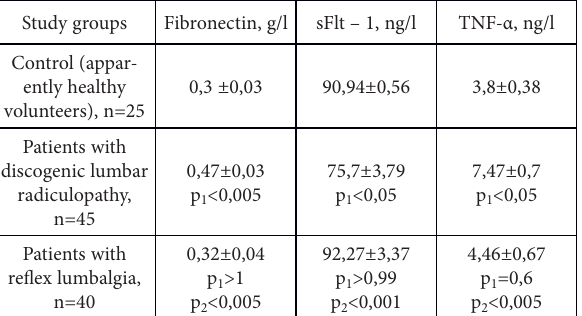
Plasma levels of fibronectin, soluble fms-like tyrosine kinase-1 (sFlt-1) and tumor necrotic factor (TNF-α) in patients with neurologic manifestations of lumbar osteochondrosis Study